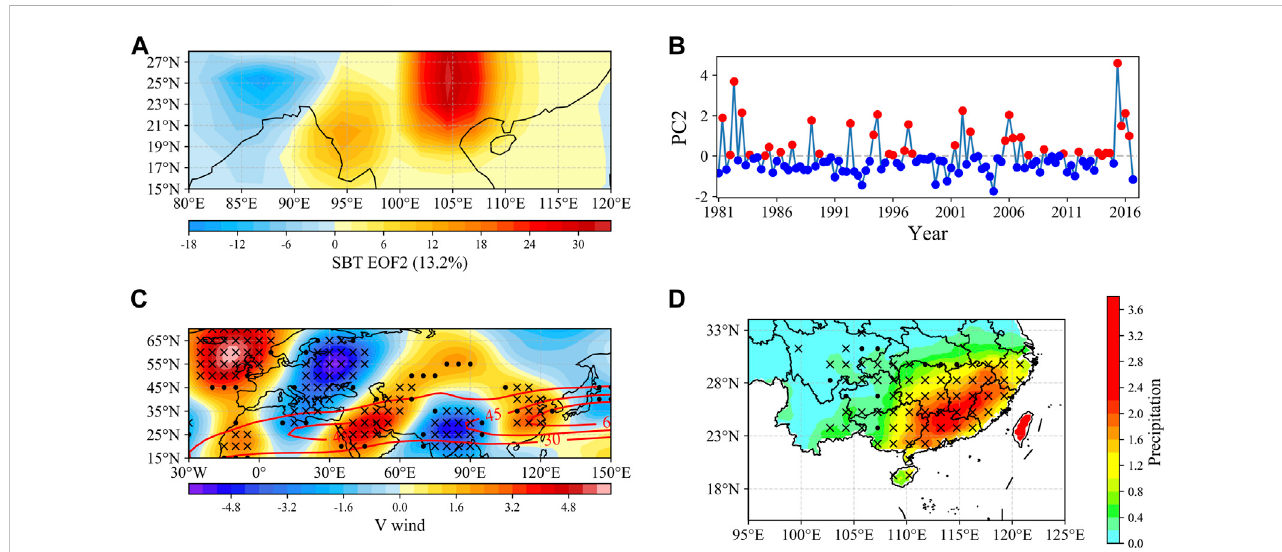
FIGURE 15 EOF2modeoftheSBTappearancefrequencyduringthetimeperiod1981 – 2016. (A) Spatialdistribution. (B) Timeseries. (C) The200 hPameridionalwind anomalies(shading;units:ms − 1 )andzonalwinds(redcontours;units:ms − 1 )and (D) theprecipitationanomalies(shading;units:mmday − 1).Thevaluesinparts (C,D) are both composited using the PC2 time series > 1.0 standard deviation. The black cross (solid circle) represents the meridional winds in part (C) and the precipitation anomalies in part (D) that are signi fi cant at the 95% (90%) con fi dence